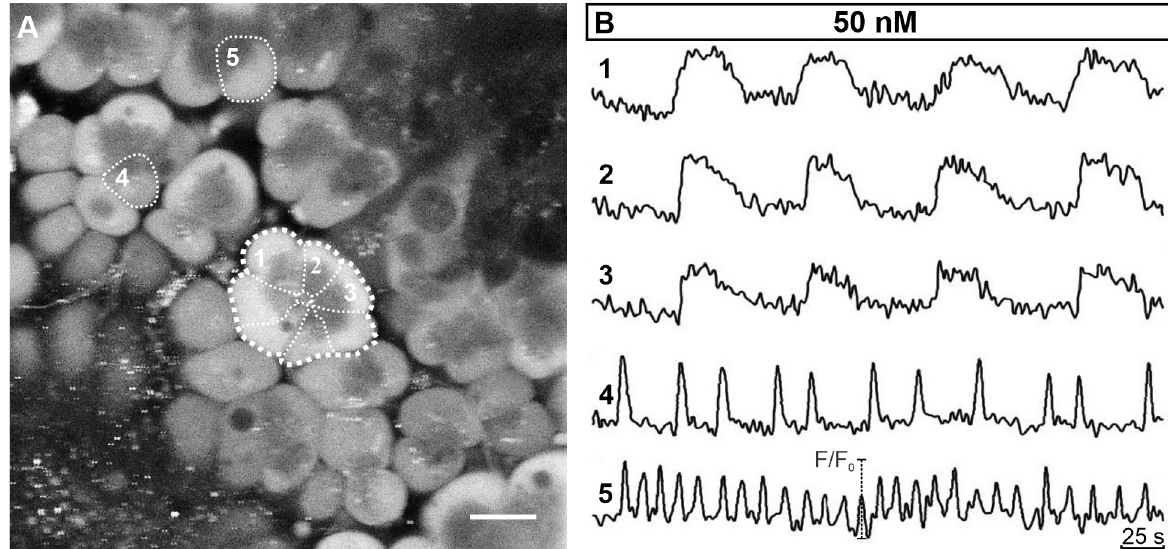
Fig 4. [Ca 2+ ] i oscillations within different acini. (A) OGB-1 loaded acinar cells in a tissue slice. Cells indicated with 1–3 belong to the same acinus (the thicker broken line marks the acinus, the thinner broken lines mark boundaries between individual acinar cells). Scale bar 20 μ m. (B) The [Ca 2+ ] i activity patterns in three different acinar cells from the same acinus (1–3) and in two cells from two other distinct acini (cells 4 and 5) stimulated with 50 nM ACh. Please note that [Ca 2+ ] i oscillations were similar in shape and synchronized between cells in the same acinus but not between cells from different acini (1–3 vs. 4 vs.